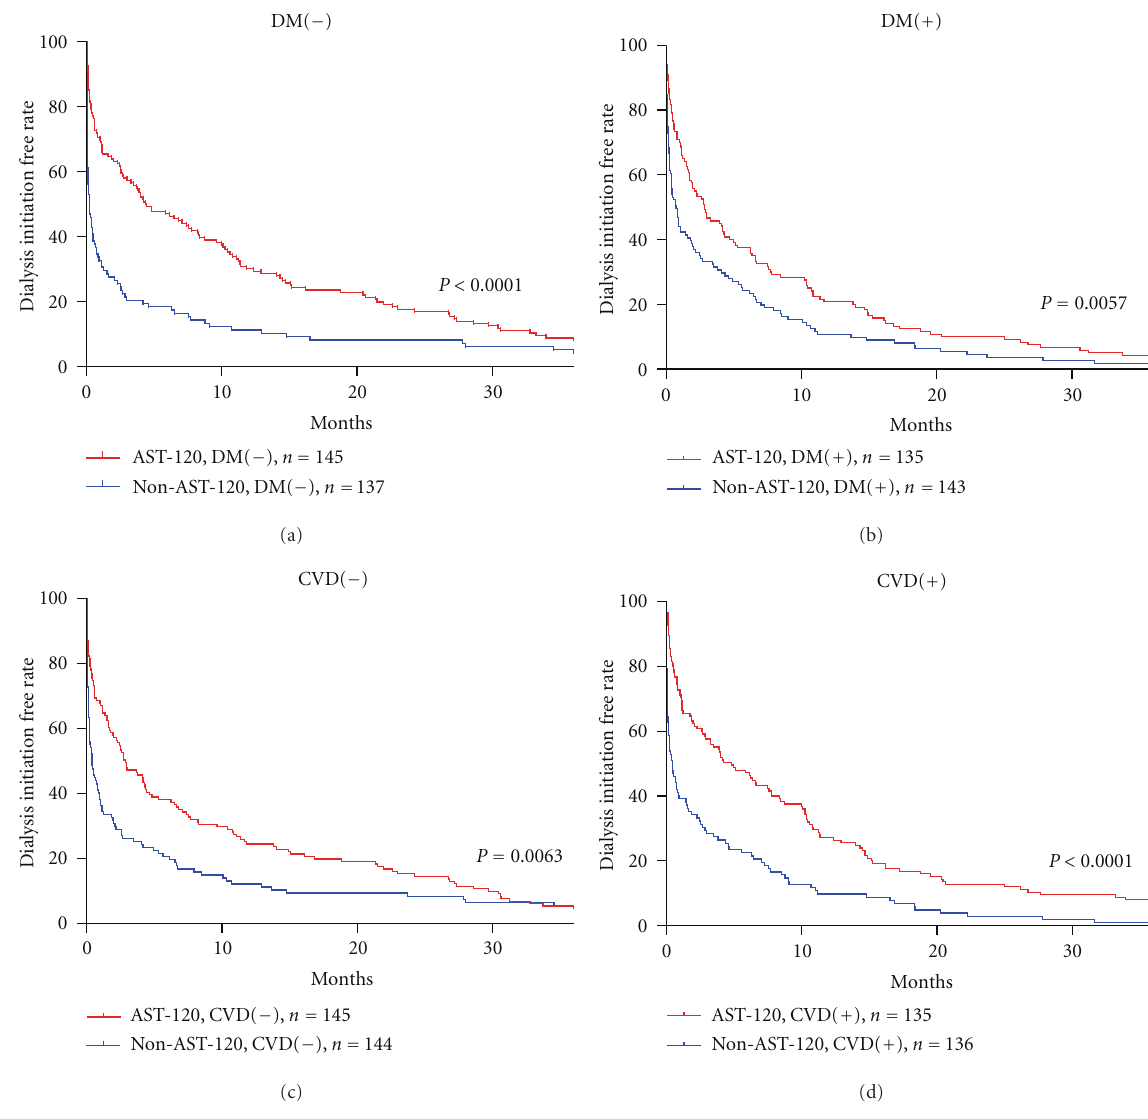
Figure 2: Subgroup analysis of the delaying e ff ect of AST-120 on dialysis initiation. The cumulative percentages of non-dialysis patients were analyzed by Kaplan-Meier methods. The dialysis initiation free rate was significantly higher in the AST-120 group than in the non-AST-120 group in all subgroups, with DM [11] (a) or without DM (b), and with CVD (c) or without CVD